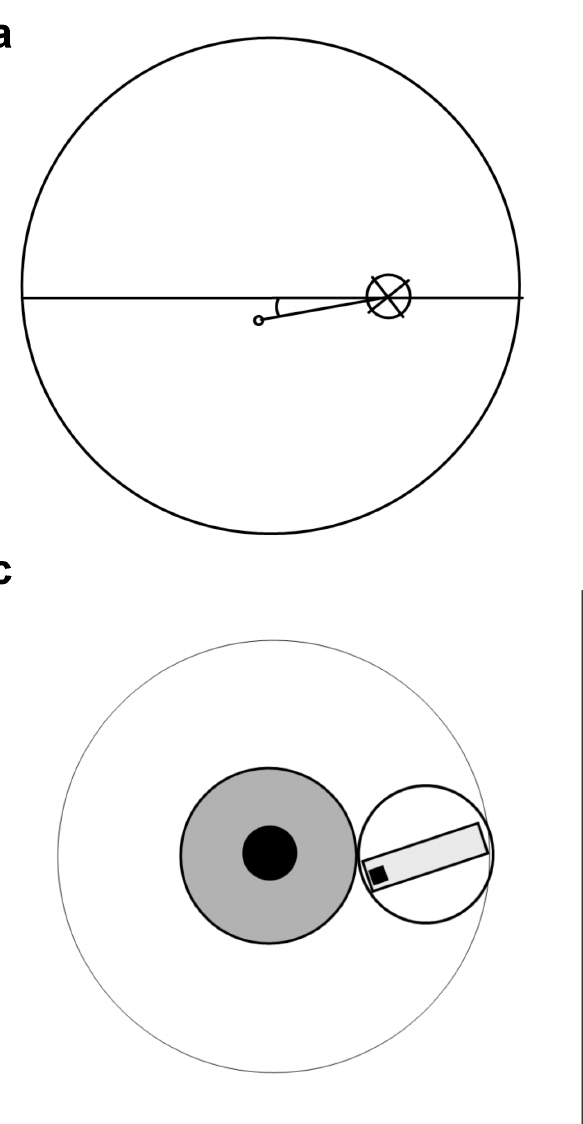
Whitney U test (non-normal distribution) was used to explore statistical differences in visual function. Pearson’s (normal distri- bution) or Spearman’s coefficient (non-normal distribution) was used to determine the correlation between measurements of the operated and the fellow eyes. For these analyses, p-values below 0.05 were considered statistically significant. Multivariate forward stepwise regression analyses were performed on the postoperative visual function variables with duration of the macular detachment, height of the macular detachment, age, gender, pre-operative BCVA, and preoperative refractive error as independent variables.